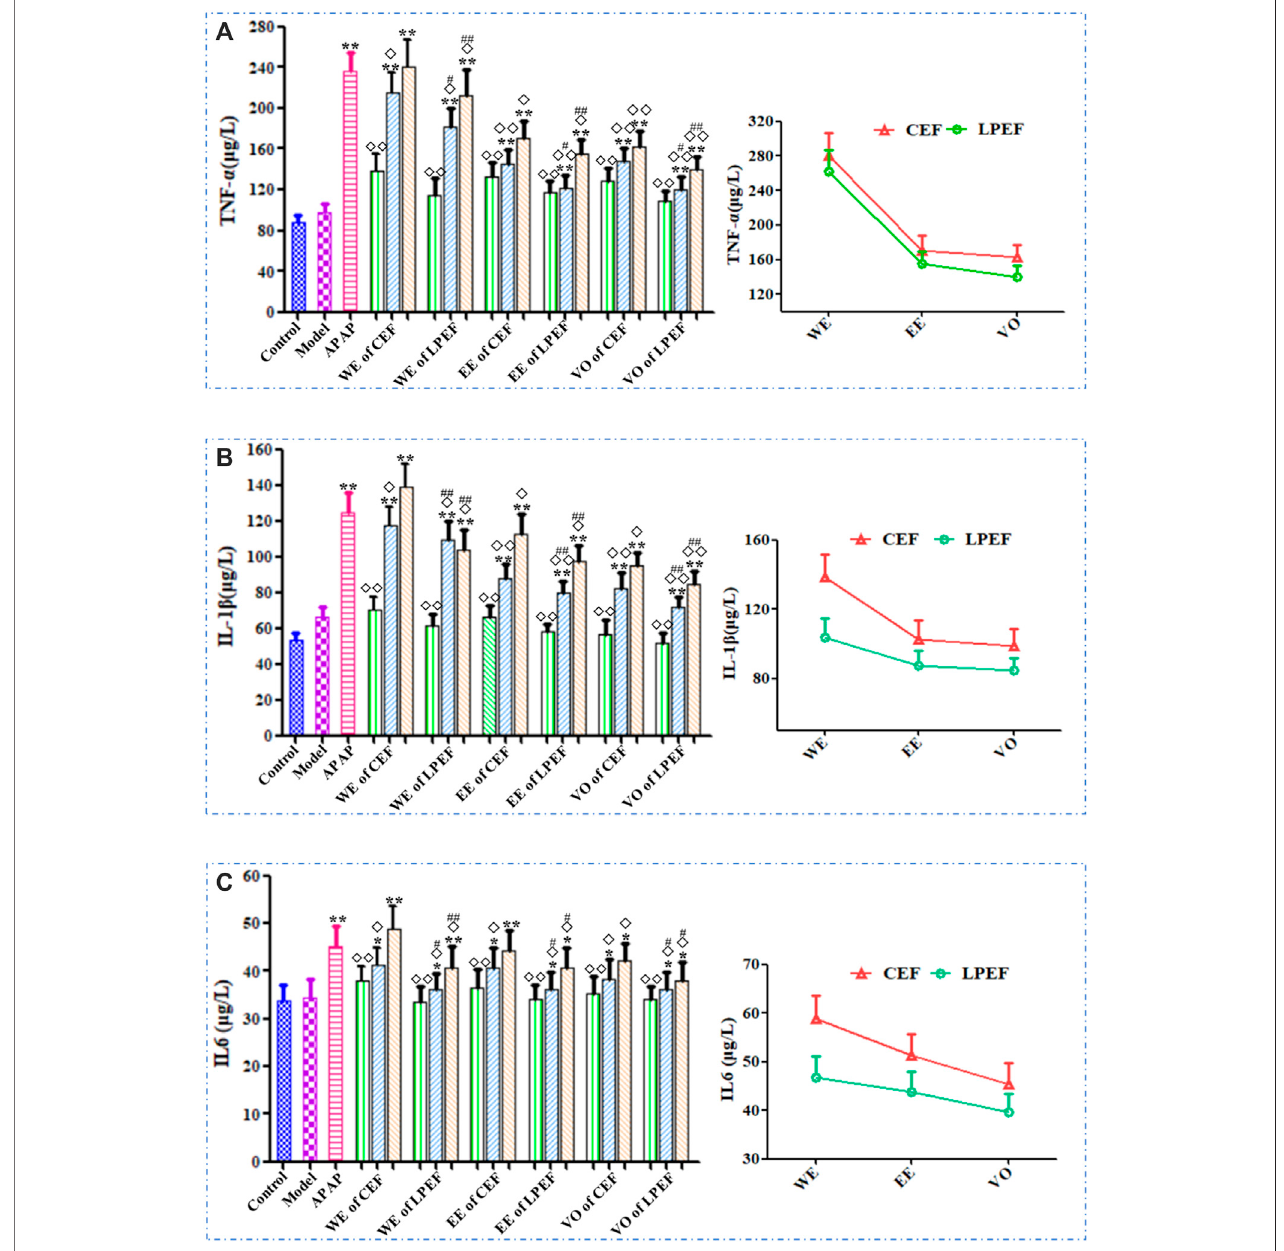
FIGURE 7 | Effects on serum in fl ammatory factors of different drugs: TNF- α (A) , IL-1 β (B) , and IL-6 (C) . Left graph: comparison between 21 groups; right graph: comparisonbetweenthreeCEFandLPEDextractsathighdose.Valuesaremean ± SDof10replicatedsamples;vs.controlgroup, p < 0.05( * )and p < 0.01( ** );vs.CEF, p < 0.05 ( # ) and p < 0.01 ( ## ); vs. APAP, p < 0.05 ( ◇ ) and p < 0.01 ( ◇◇ ). 10.5 g kg − 1 , 5.25 g kg − 1 , 1.05 g kg − 1 .